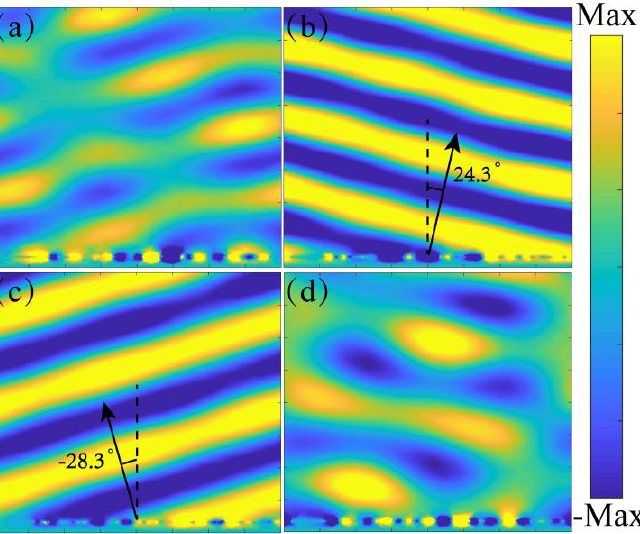
Figure 6. Simulated electric distributions of anomalous reflection with conductivities of ( a , b ) 0 S/m and ( c , d ) 3 × 10 5 S/m.